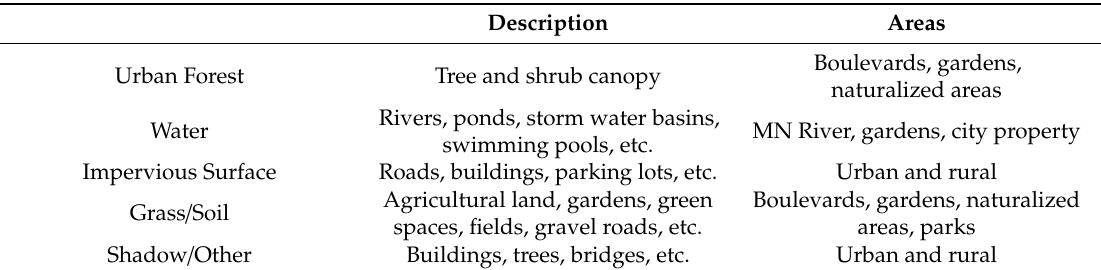
Table 4. Description of Land